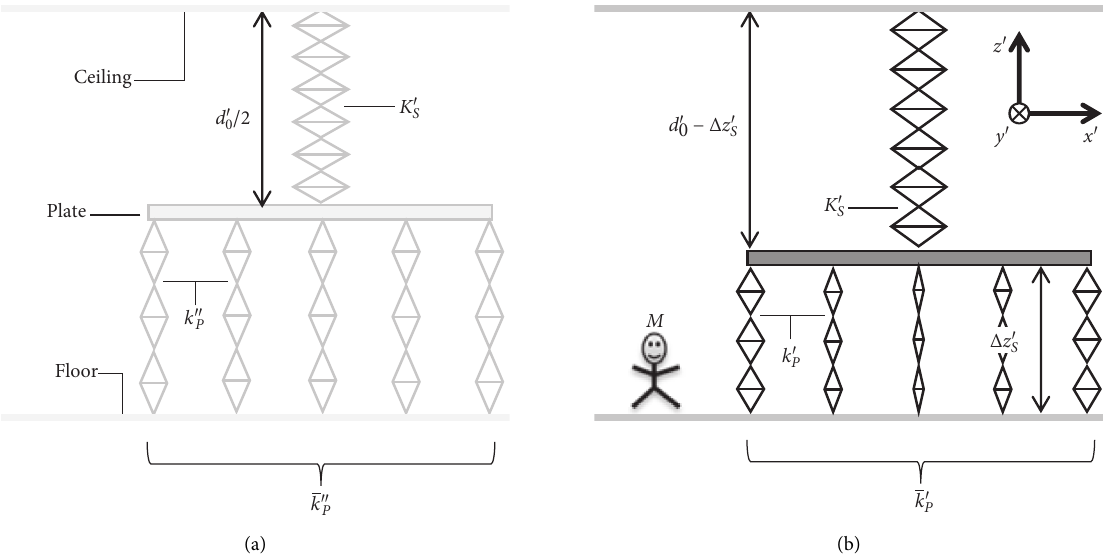
Figure 2: The multispring system as viewed in plane x ′ z ′ . (a) Before the rotation of the plate, the plate is balanced at the midpoint between the ceiling and the floor since k P ″ � K S ′ . (b) In the process of rotation of the plate, the P springs are weakened ( k P ′ < K S ′ ), and thus, the plate finds its equilibrium state somewhere below the previous location. In this case, the final displacement of the P springs is supposed to be d ′ − Δ z S ′ where Δ z S ′ is the displacement of the spring S . Recall that the middle spring of the rotating plate is shown thinner in size due to 0 maximum speed and maximum Lorentz contraction along the x ′ -axis.